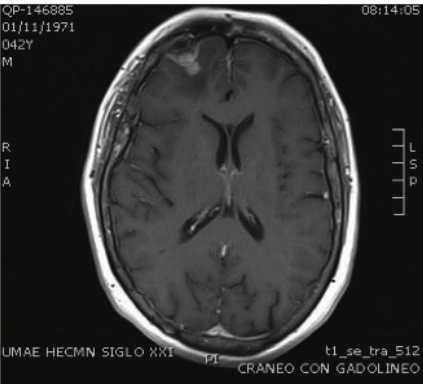
Figure 3: Brain MRI. Image in T1 shows a right frontal tumor of 19 × 21 × 19mm with associated edema.